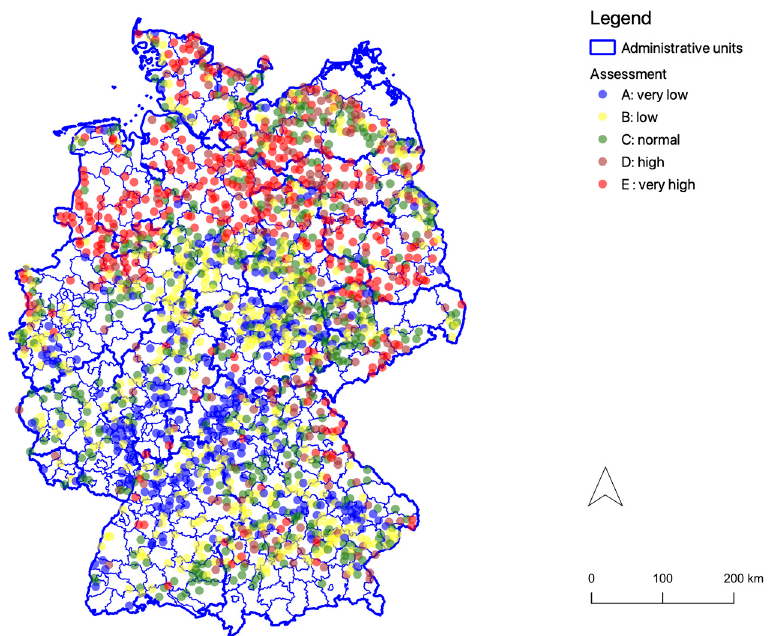
Figure 4. Frequency distribution of humus levels in Germany according to the VDLUFA balance method based on the actual observed SOC. Classes are A: very low, B. low, C: normal, D: high, and E: very high.